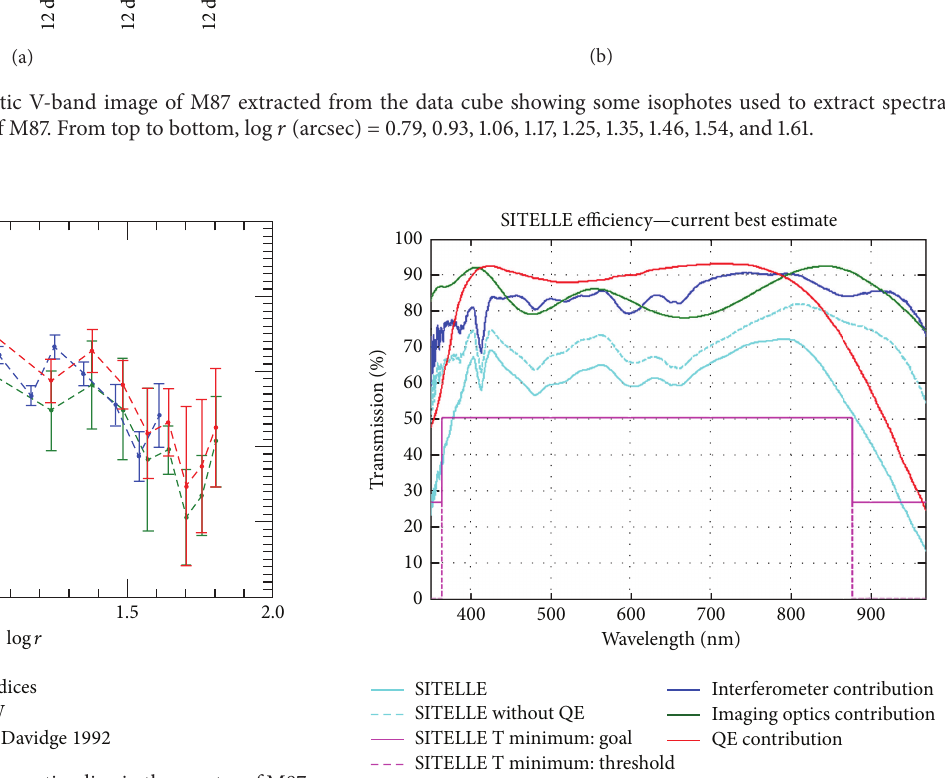
Figure 14: SITELLE’s expected combined throughput, including modulation